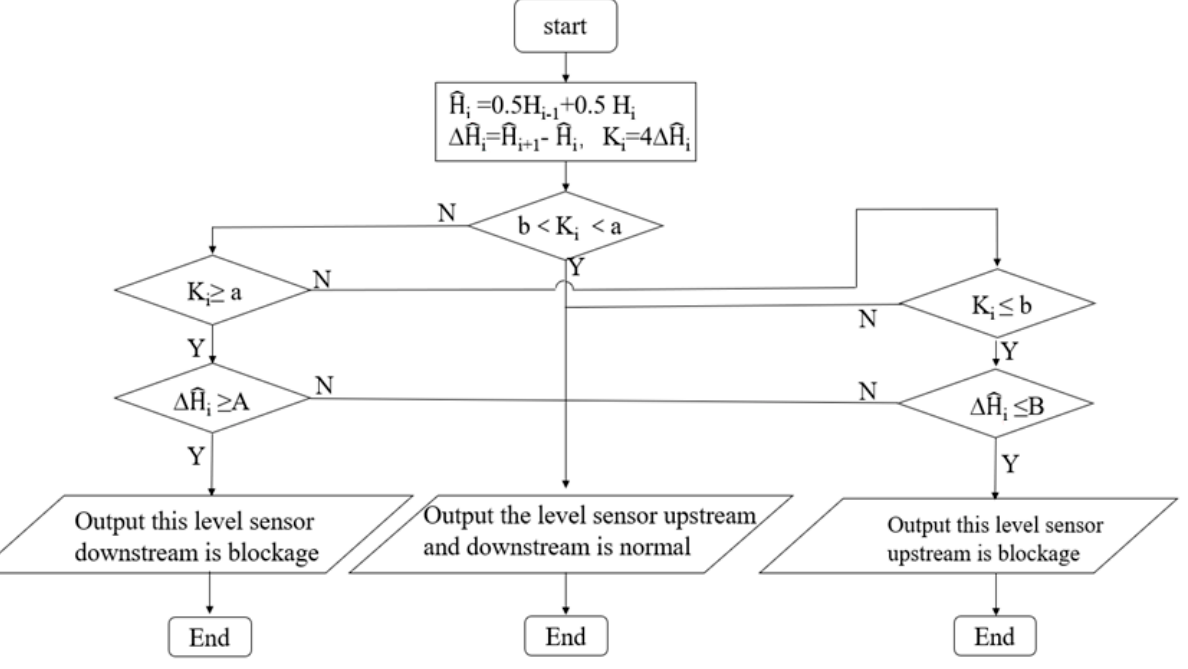
Figure 4. Diagram of the sewer blocking identification procedure.